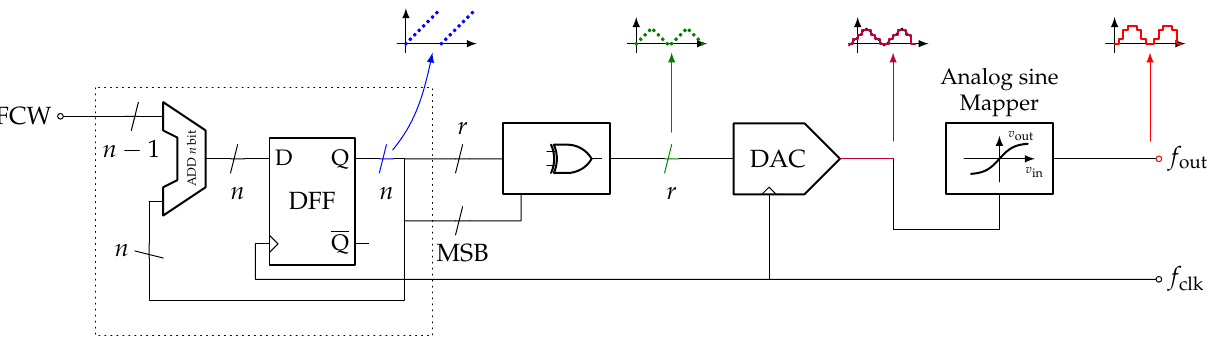
Figure 14. RF-DDFS with an analog sine mapping.